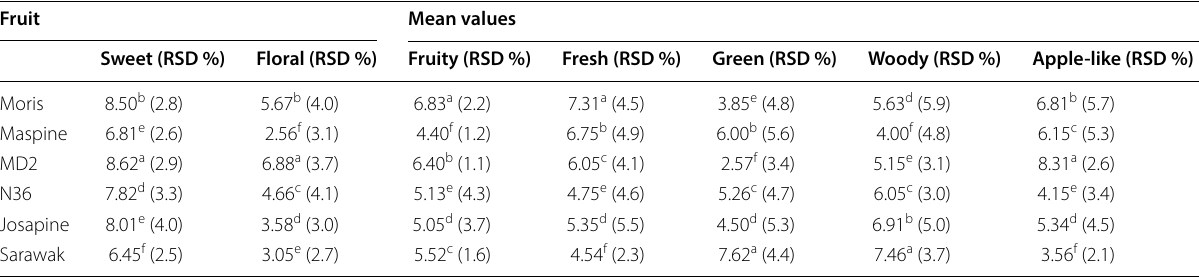
Superscripts with different letters are significantly (p < 0.05) different